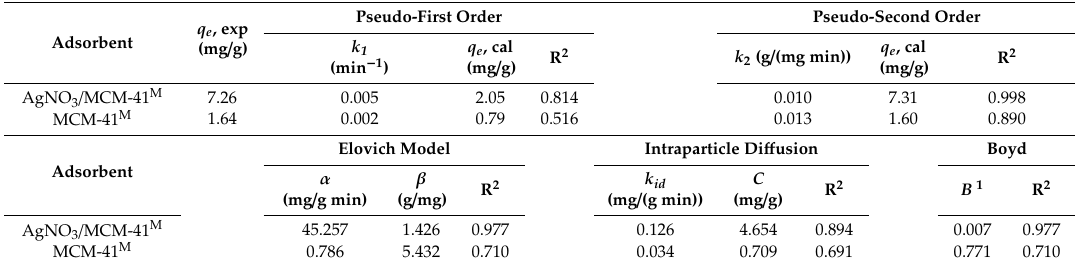
Table 3. Kinetic parameters fitted to pseudo-first order, pseudo-second order, Elovich, intraparticle di ff usion and Boyd models. Experimental conditions: room temperature and pressure, 500 ppm sulfur real